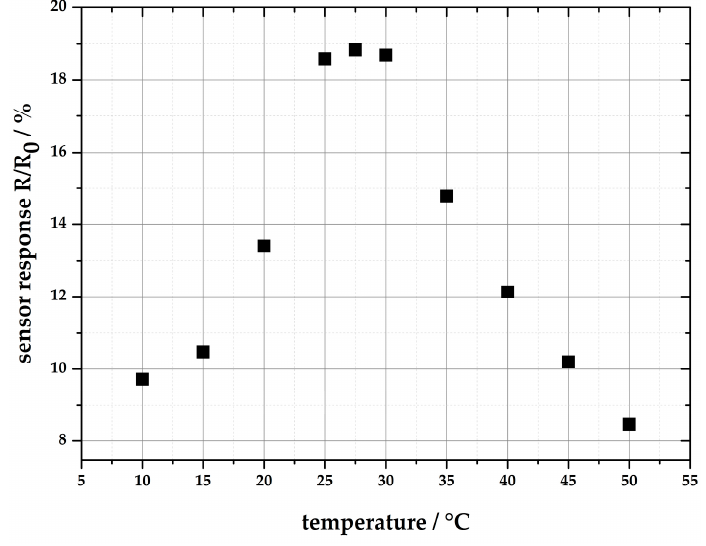
Figure 11. Temperature dependence of the maximum signal shift of 2 · (A) 2 at different reaction temperatures between 10 °C and 50 °C. The colored silica was exposed to 300 ppm CO.